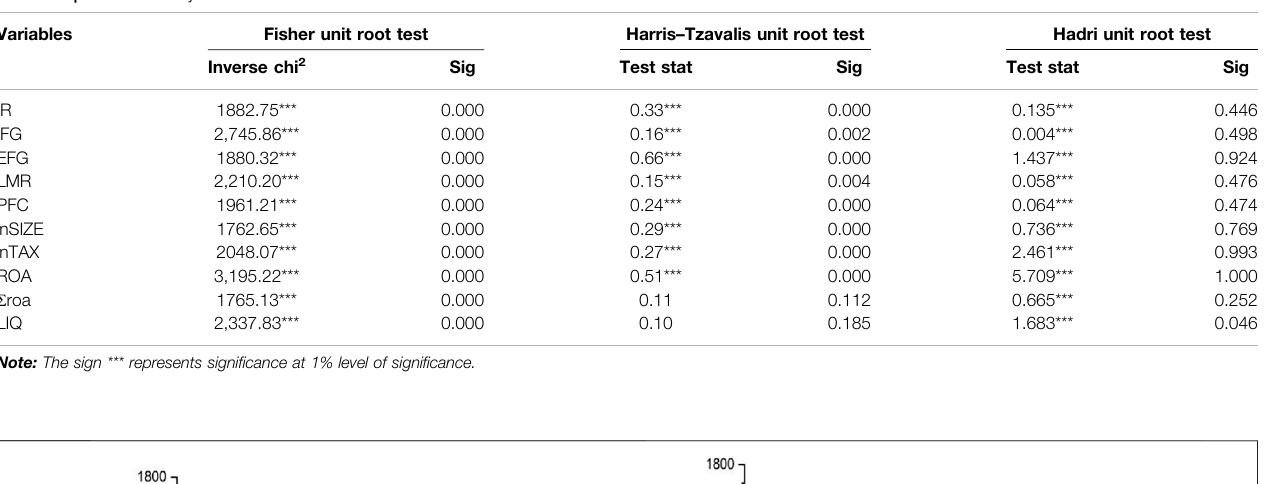
heterogeneity, autocorrelation and cross sectional dependence issues prevalent in our panels.